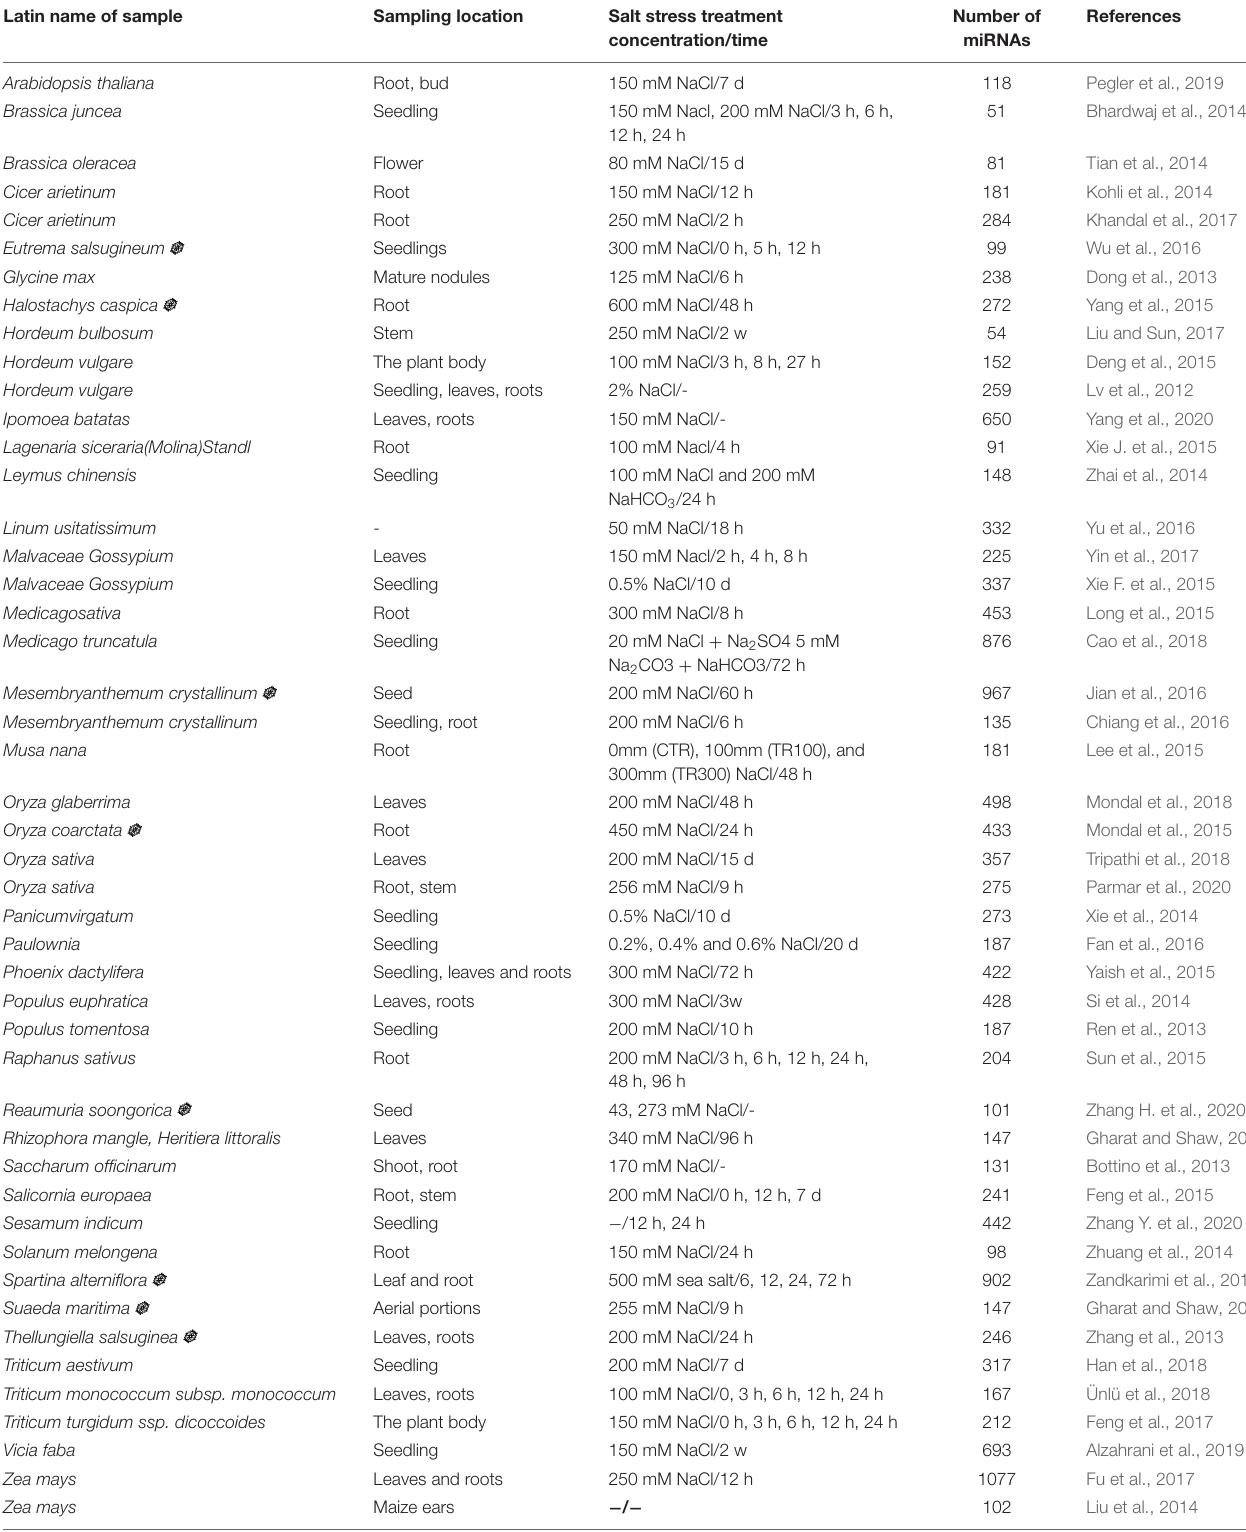
TABLE 1 | The identification of plant miRNAs under salt stress by